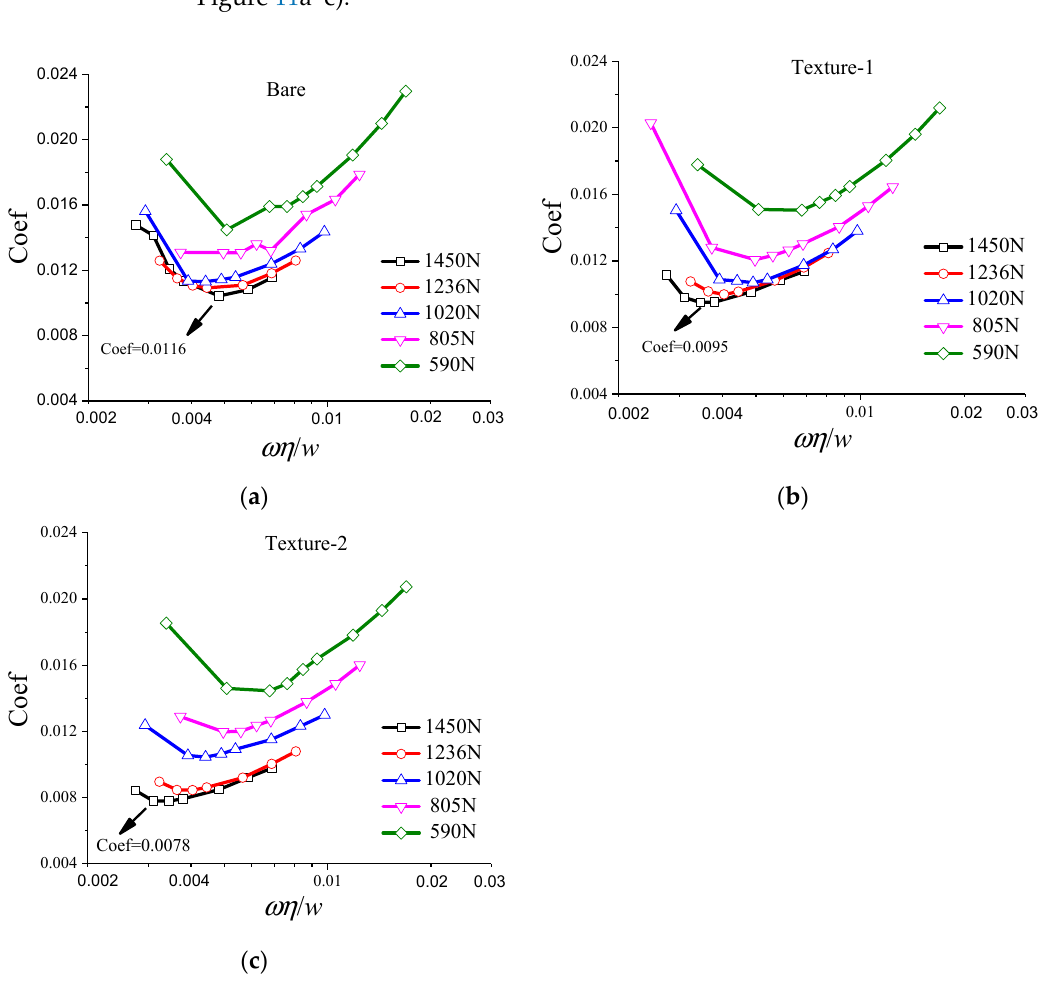
Figure 11. Stribeck curve of ( a ) bare, ( b ) textured-1, and ( c ) textured-2 gear washers.